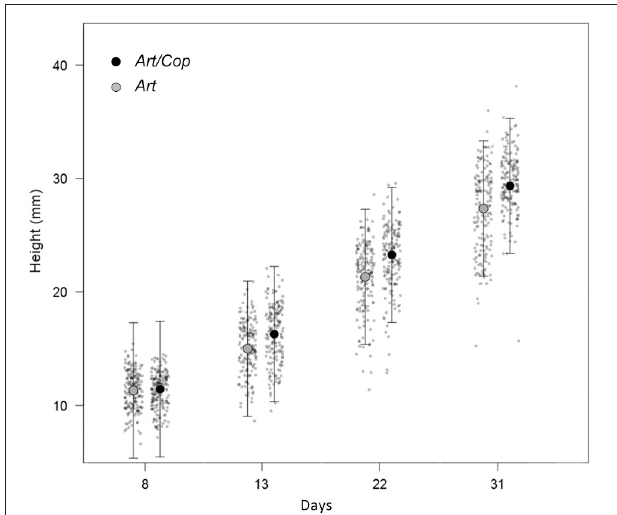
FIGURE 2 | Jitter plots (gray dots) showing differential height increases of Hippocampus reidi specimens over time, depending on dietary treatments. Raw measures are overlaid by mean heights and their 95% confidence intervals as estimated by a linear mixed-effect model using the predictors treatment, time, a quadratic term of time, and the interaction between time and treatment.